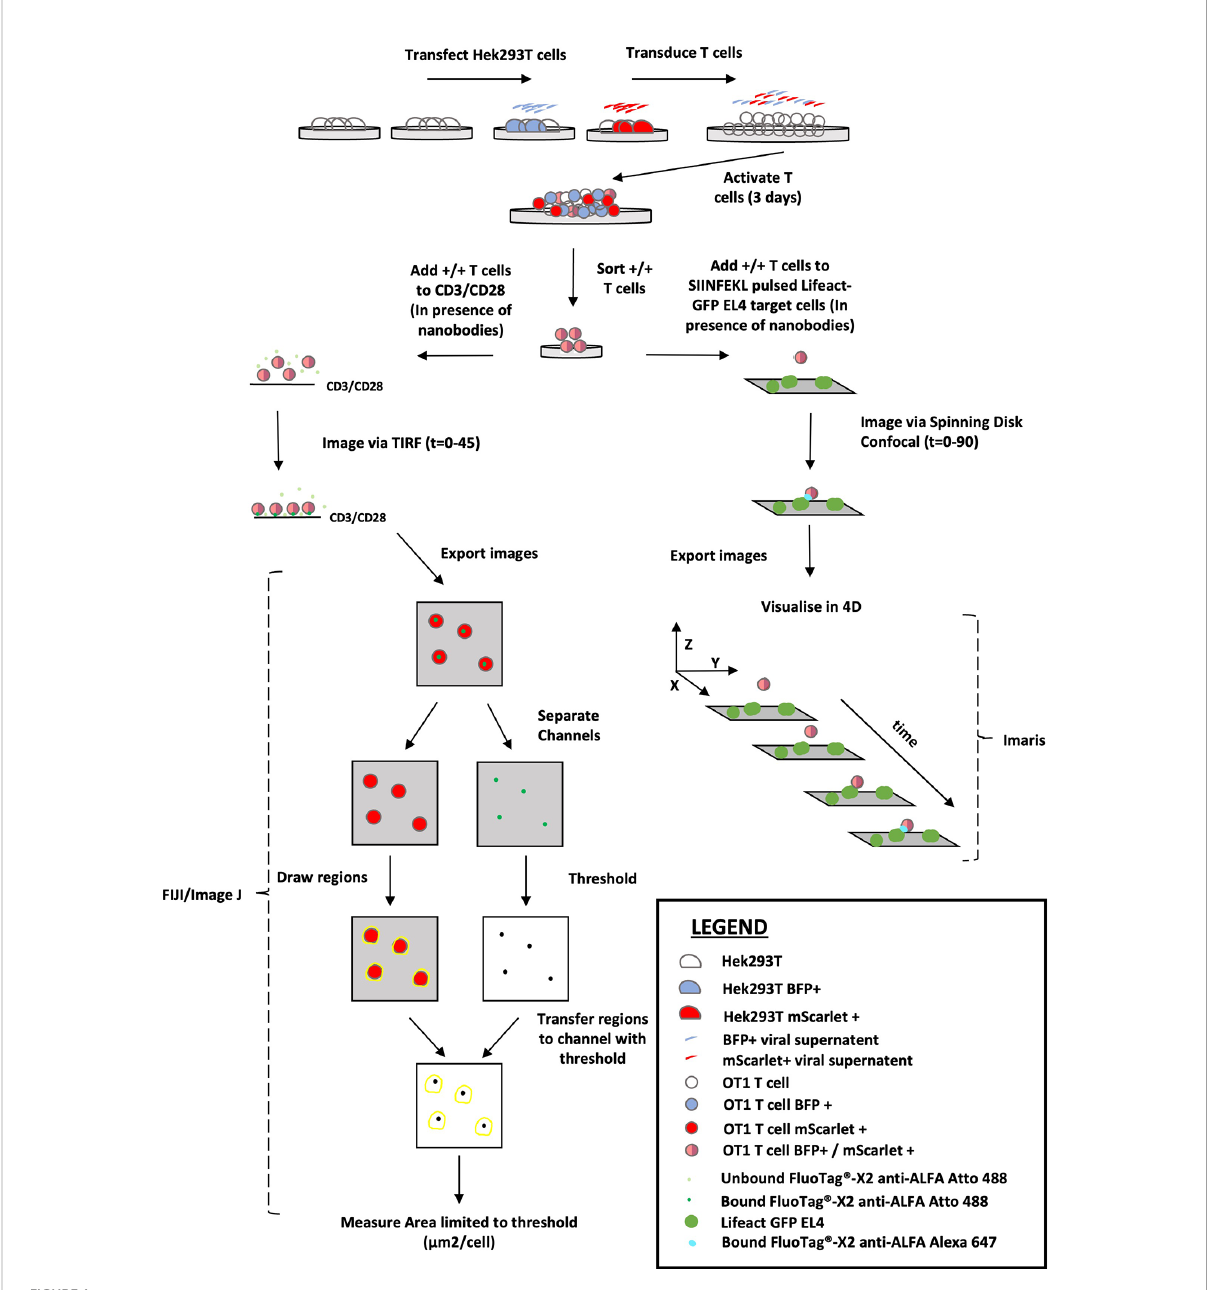
FIGURE 1 Overview of the ALFA-PRF Technique. Virus produced from HEK293T cells transfected with either MSCV-ALFA-PRF-TagBFP (BFP +) or MSCV- Lifeact-mScarlet (mScarlet +) is pooled and used to transduce OT1 T cells on Day 0 of activation. After 3 days of activation, the transduced T cells are sorted via fl ow cytometry to collect a pure population of double positive (+/+) cells. These double positive cells are then utilised in one of two ways: 1) added to CD3/CD28 coated imaging chambers in the presence of FluoTag ® -X2 anti-ALFA Atto 488 nanobody and imaged via TIRF for 45 minutes. Resultant images are exported as OME TIFFS and opened in FIJI/Image J. Channels are separated so regions can be drawn around the lifeact-mScarlet signal, and then these regions are transferred to the thresholded (to highest grey value within synapse area in the Empty Vector control) FluoTag ® -X2 anti-ALFA Atto 488 Channel image. An area measurement limited to threshold is then performed to obtain a value of perforin signal (µm 2 /cell). 2.) Added to SIINFEKL pulsed EL4 target cells that are also transduced with Lifeact-GFP, in the presence of FluoTag ® -X2 anti-ALFA Alexa 647 nanobody and the immune synapse interaction visualised by spinning disk confocal microscopy to generate 4D